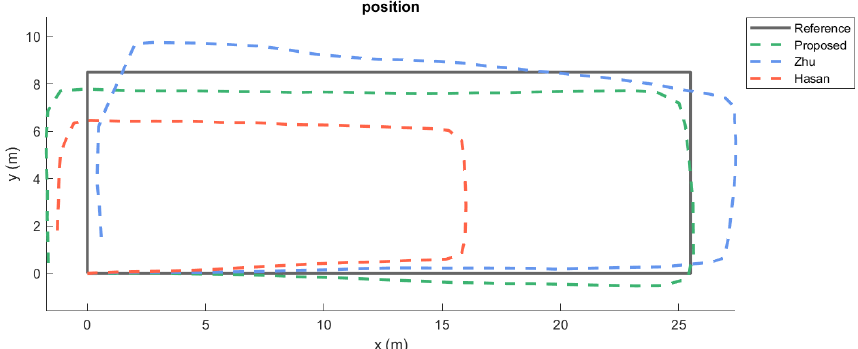
Figure 6. Estimated trajectories for the three methods plotted against the ground-truth for a head-mounted smart phone. The measurement is from one